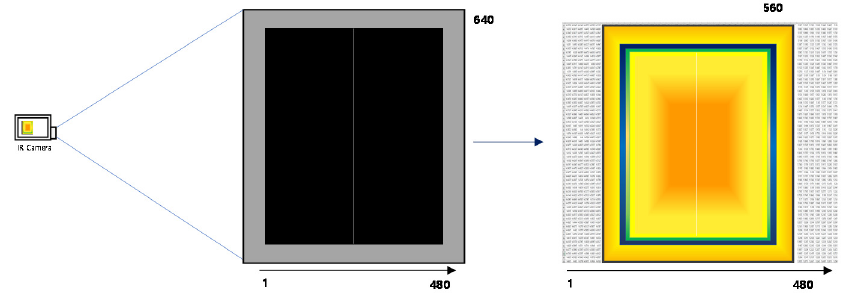
Figure 4. Window measurements using the infrared (IR) method. Table 4. Measurement cases using the IR method.